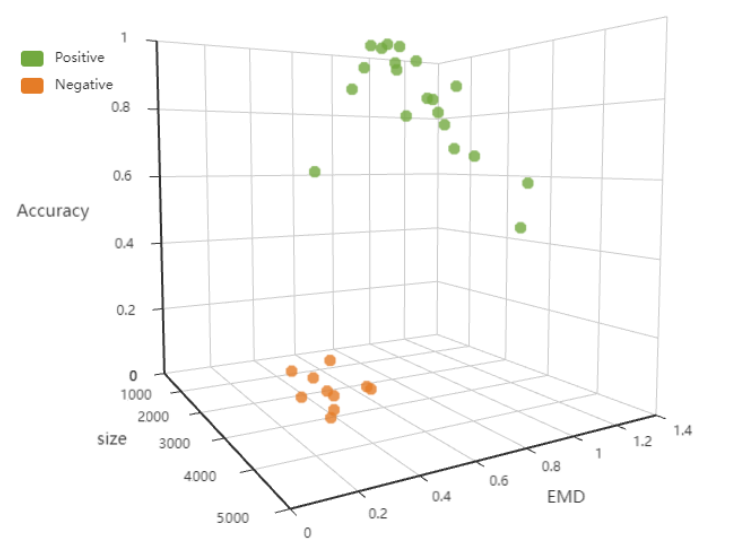
Figure 6. The clustering detection effect diagram of negative behaviors.